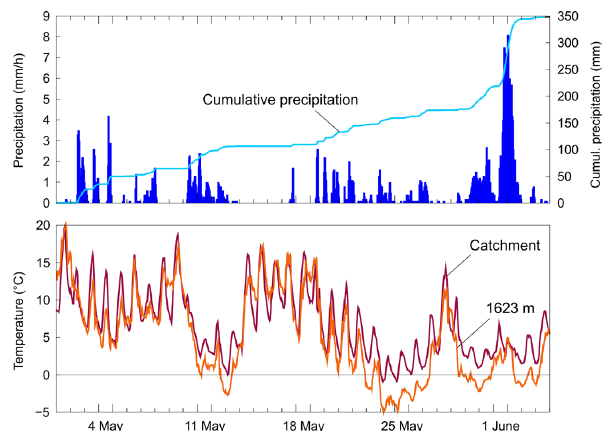
Fig. 5. (top) Catchment precipitation for the Weißbach catchment (567km 2 ) in May and June 2013 (dark blue shows hourly intensi- ties, light blue cumulative precipitation). (bottom) Catchment av- erage temperatures for the Weißbach catchment (dark red) and air temperature at the Loferer Alm station (1623ma.s.l.,